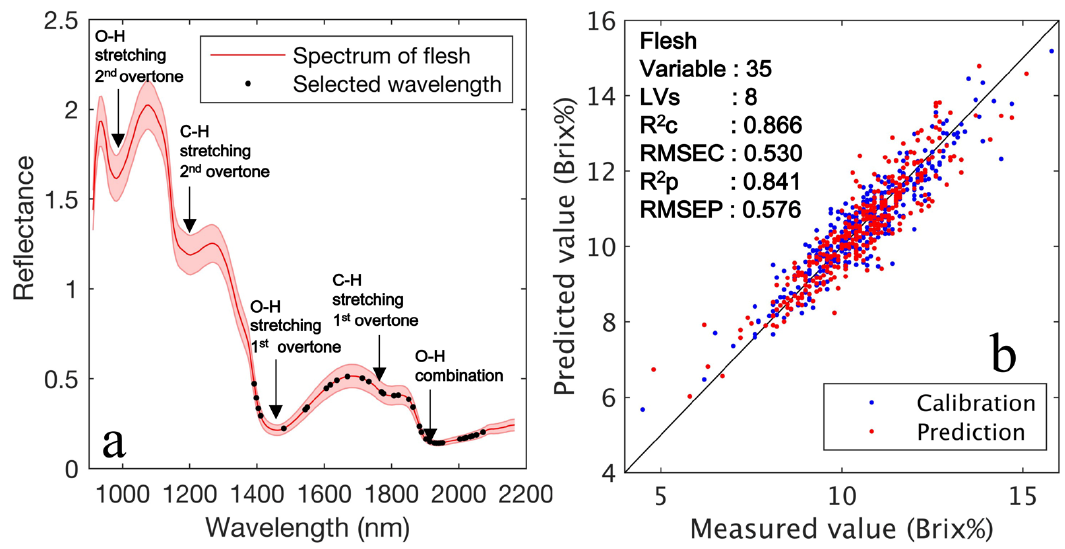
Figure 9. ( a ) Total of 35 key wavelengths (black points) selected by CARS method. ( b ) PLSR calibration result with training data set and prediction with testing dataset using the selected 35 key wavelengths and 8 LVs; the R 2 c and RMSEC are 0.866 and 0.530, whereas R 2 p and RMSEP are 0.841 and 0.576, respectively.